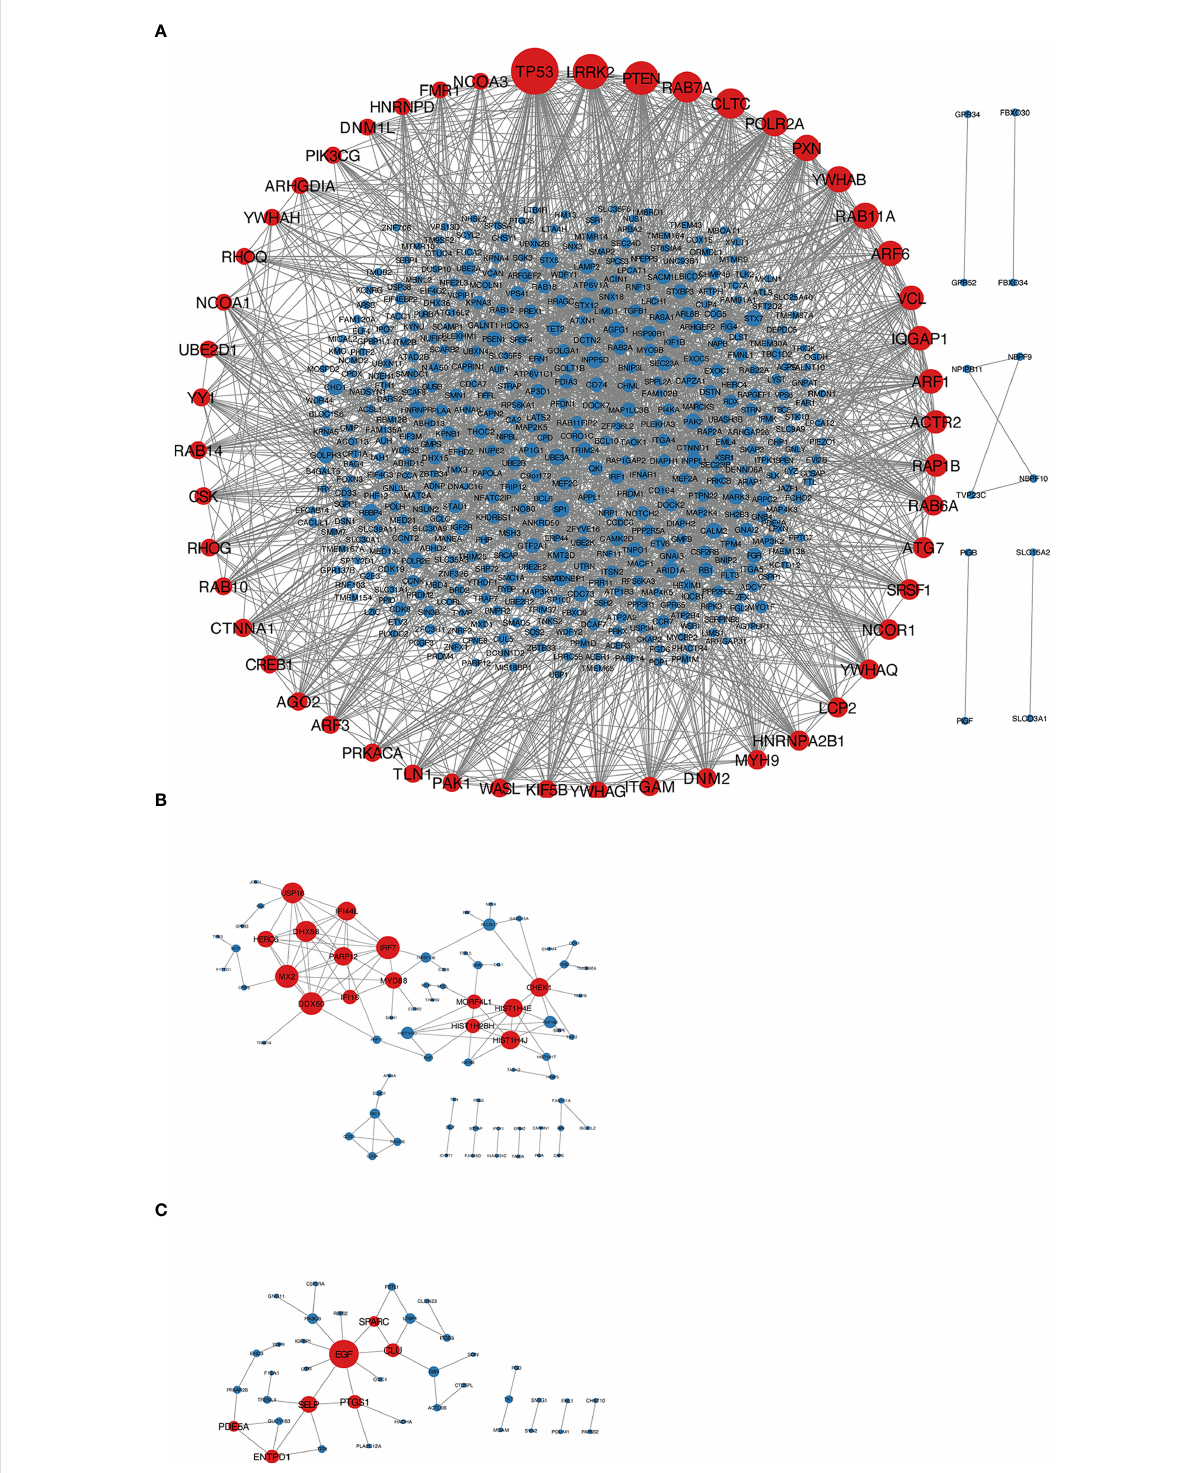
FIGURE 3 (A) Target genes of CD4 + T cells in MS patients treated with Fingolimod, red nodes were hub target genes; (B) target genes of pDCs in MS patients treated with IFN- b , red nodes were hub target genes; (C) target genes of PBMC in MS patients treated with IFN- b , red nodes were hub target